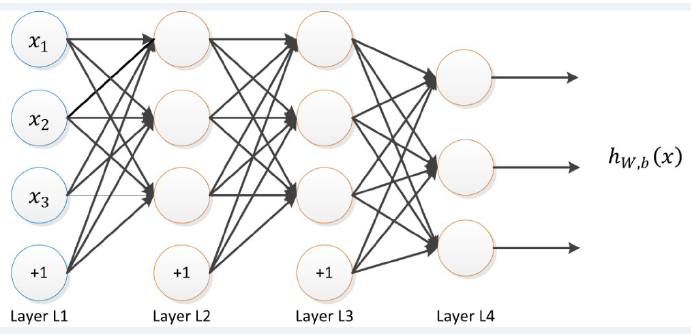
Figure 2. The sketch map of the neural network